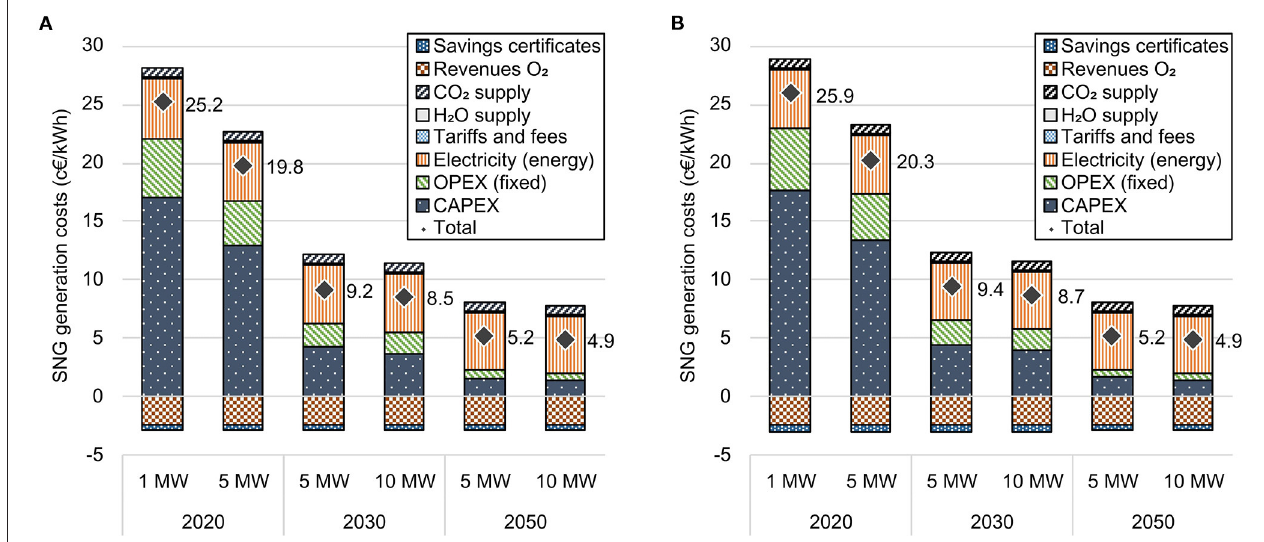
FIGURE 7 | SNG generation costs for different plant capacities and years of implementation. (A) steel industry scenario, (B) cement industry scenario.